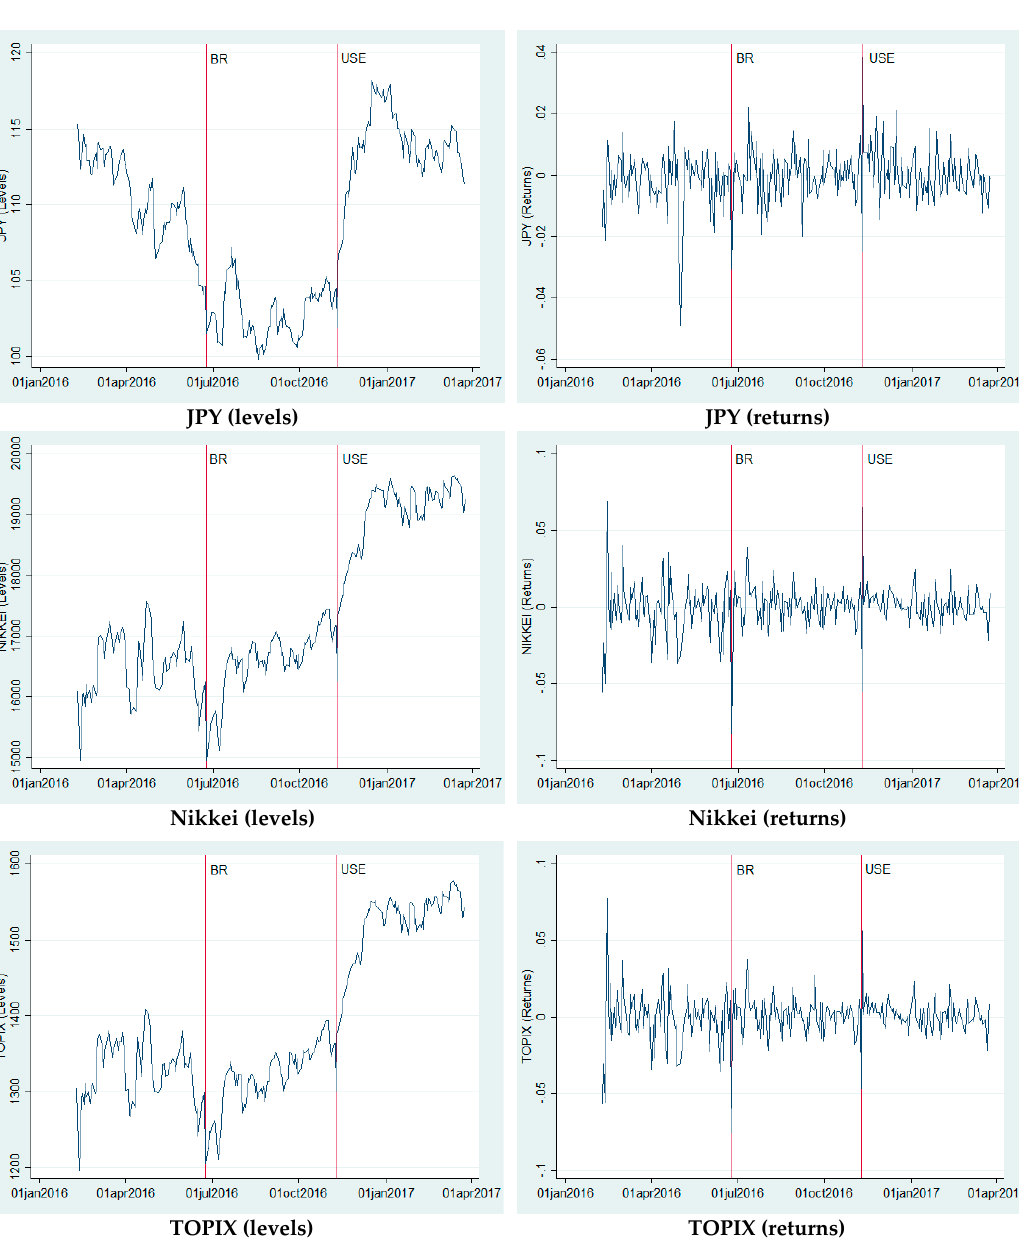
Figure 1. Levels and returns for the exchange rates and stock price indexes.